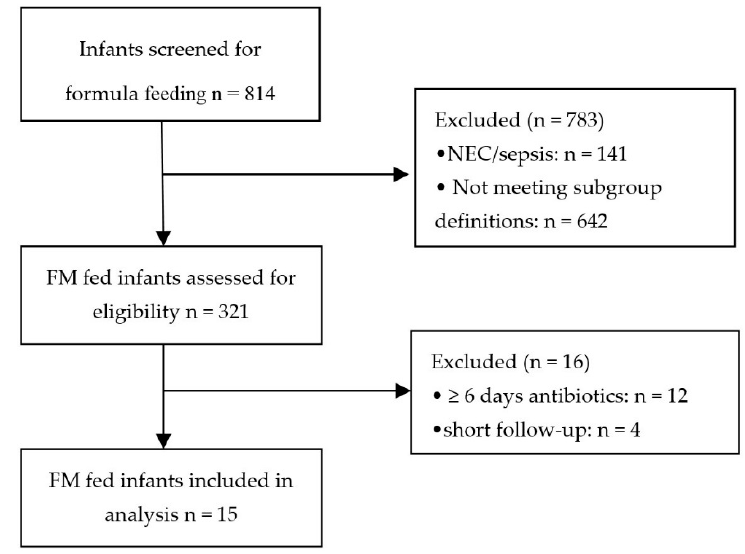
Figure 1. Flowchart inclusion process for formula milk fed infants. Abbreviations: NEC = necrotizing enterocolitis; FM = formula milk; and n = number.